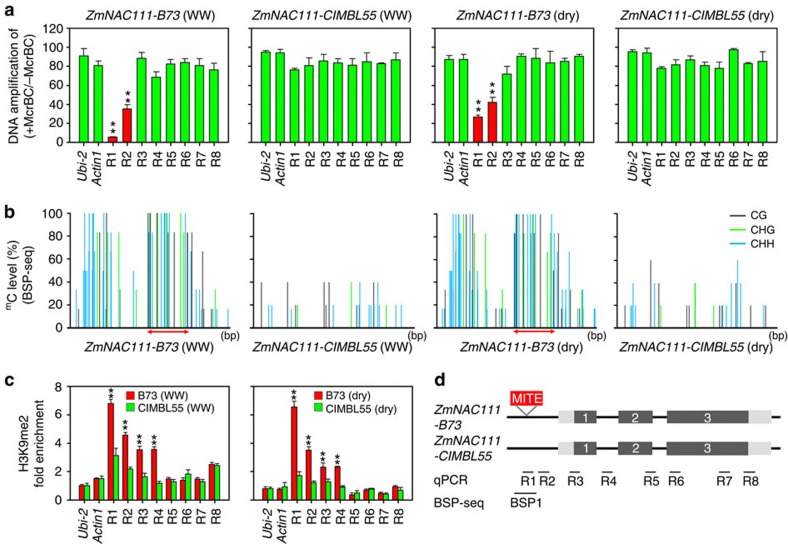
DNA and H3K9me2 methylation status of the drought-tolerant and drought-sensitive alleles of ZmNAC111.(a) DNA methylation status was determined by treatment with McrBC, a methylation-sensitive endonuclease followed by qPCR (McrBC–qPCR) analyses in the eight regions (R1–R8) of the genomic sequence of ZmNAC111. Genomic DNA was extracted from B73 and CIMBL55 genotypes grown under well-watered (WW) and moderate drought (dry, RLWC=70%) conditions. (b) Methylation of cytosine residues in CG, CHG and CHH sites (grey, green and blue lines, respectively) was revealed by bisulphite sequencing of the BSP1 region. The DNA samples of (a) were analysed. The MITE region is indicated by a double-sided arrow. (c) Chromatin state was detected using an anti-H3K9me2 ChIP–qPCR assay at eight different regions (R1–R8) of the genomic regions of ZmNAC111-B73 and ZmNAC111-CIMBL55. The H3K9me2 state of the maize Ubi2 and Actin1 were tested in parallel as negative controls. Anti-H3 was used as an internal reference in the ChIP–qPCR assay. (d) The positions of R1–R8 in the genomic region of ZmNAC111. The 5′- and 3′-UTR regions (light grey boxes), exons (grey boxes) and 82-bp MITE insertion (red box) are illustrated. Black lines indicate the position of the McrBC–qPCR, ChIP–qPCR and bisulphite sequencing (BSP1) analyses. Error bars are s.d. and significant differences are determined using the t-test, **P<0.01.